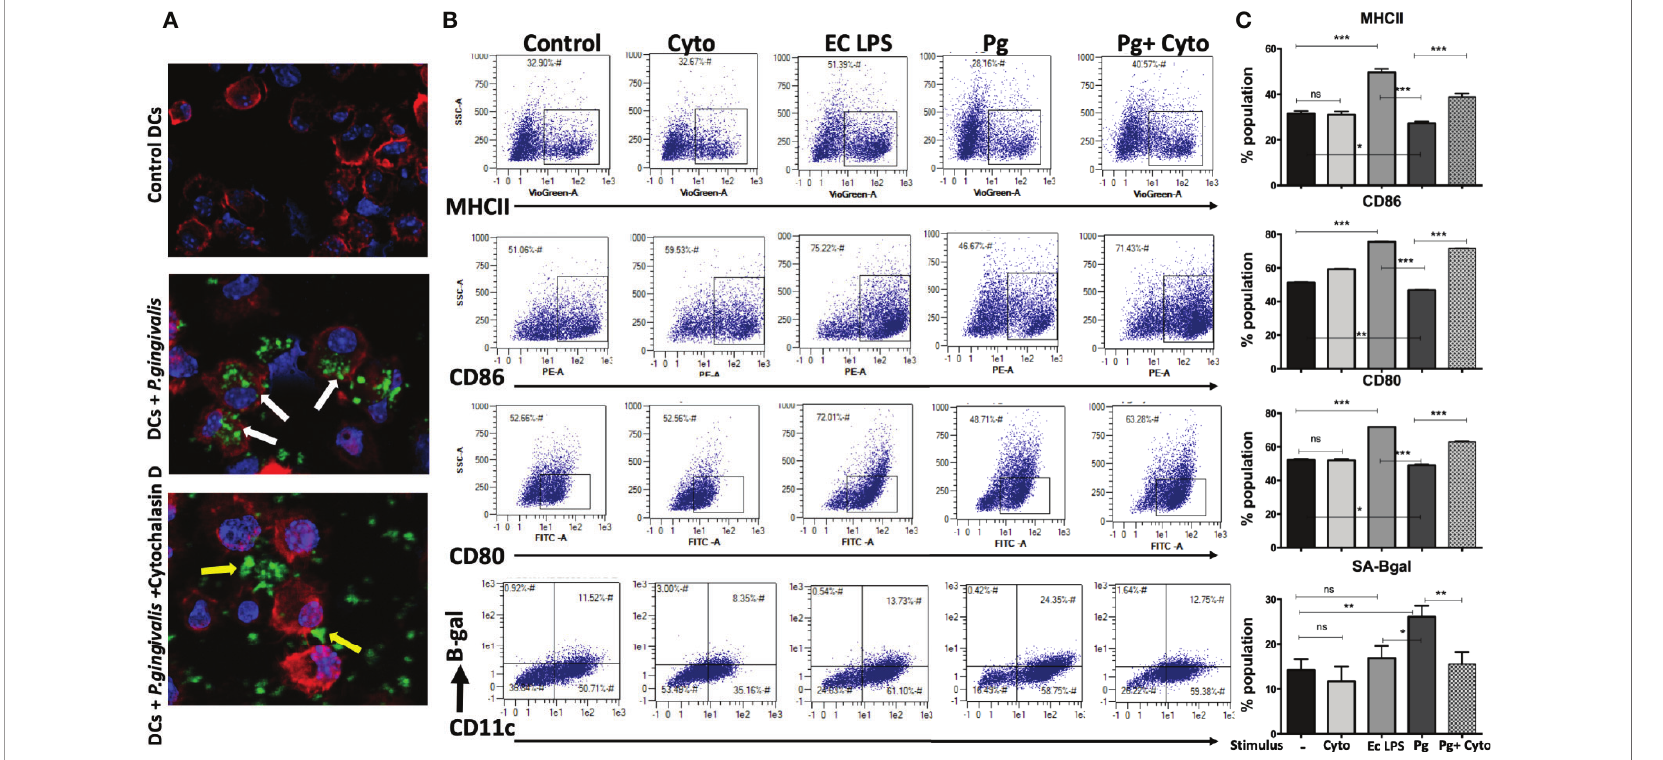
FIGURE 3 | P.gingivalis -induced senescence and impaired maturation in yDCs is abrogated by inhibition of its uptake by DCs. At day 6, yDCs were co-cultured with P.gingivalis (10MOI) ± Cytochalasin D (1ug/ml), or cytochalasin D alone, or E-coli LPS. Cells were harvested at day 8 and analyzed by fl ow cytometry for the expression of maturation markers, MHCII and co stimulatory molecules CD80 and CD86 and SA- b -gal. (A) Representative confocal microscopy images showing uptake (white arrows) of CFSE labeled P.gingivalis (green) into DCs with labeled actin (red) and counterstained with DAPI for nuclear staining (blue). Yellow arrows indicating the inhibition of uptake and accumulation of CFSE labeled P.gingivalis on the outer surface of the cell. (B) Flow cytometry scattergrams showing effect of inhibition of P.gingivalis uptake using cytochalasin D on expression of maturation markers, measured by % population of MHCII( fi rst panel), CD86 (second panel) and CD80 (third panel) and activation of senescence marker SA- b -gal (fourth panel). All gated on CD11c + cells (gate not shown). (C) Summary bar graphs of the fl ow cytometry data). Analysis was done using one-way ANOVA and Tukey multiple comparison post hoc test (Data are expressed as means ± SD, *p<0.05, **p<0.01, ***p<0.001). NS, not signi fi